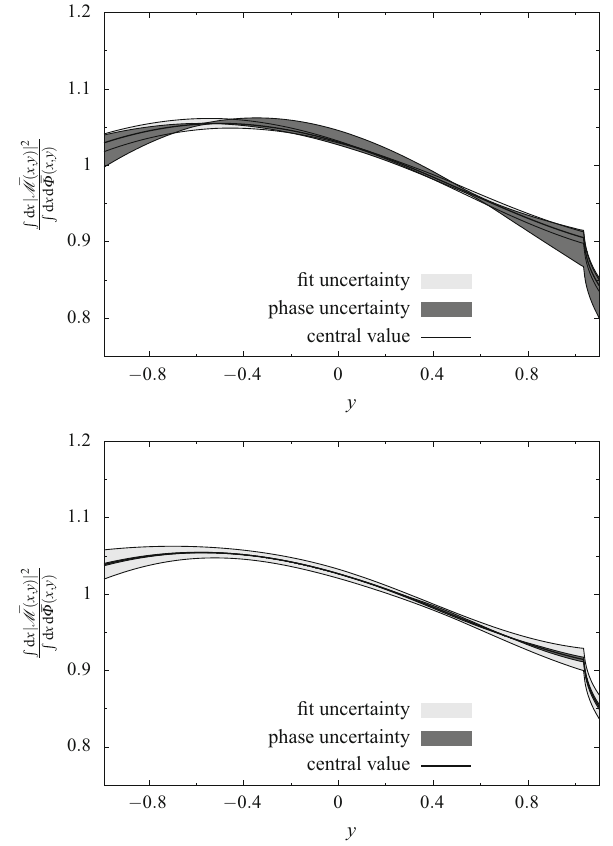
Fig. 9 Decay spectrum for η (cid:2) → ηπ 0 π 0 integrated over the variable x and divided by the integral over the normalized phase space d ¯ (cid:19)( x , y ) , where both are individually normalized as given in Eq. (37). The pre- diction is based on the BES-III fit result for subtraction constants of the charged decay; see Tables 2 and 3. The DR 3 ( upper panel ) and DR 4 fit results ( lower panel ) are shown. The two error bands in each figure give the uncertainties resulting from the fit to data and originating from the variation of the phase input,